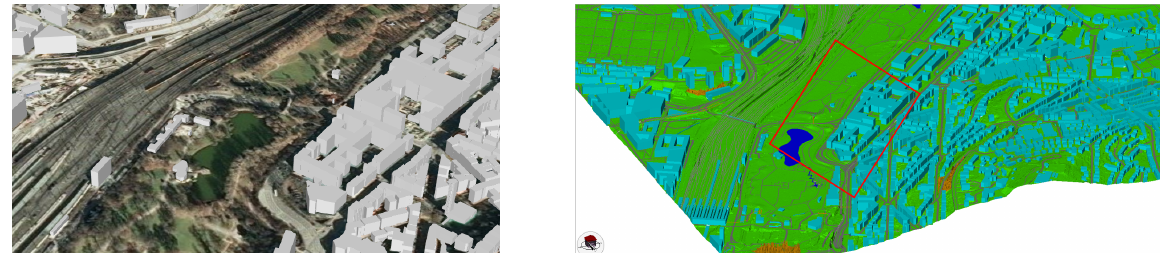
Figure 2. Study area and surroundings. ( Left ) Overview with buildings (LoD1) and vegetation as aerial photograph. ( Right ) 3D-DLM. The red rectangle shows the location of the area that is modeled in detail. 3D building model: c (cid:13) Landeshauptstadt Stuttgart, Stadtmessungsamt,